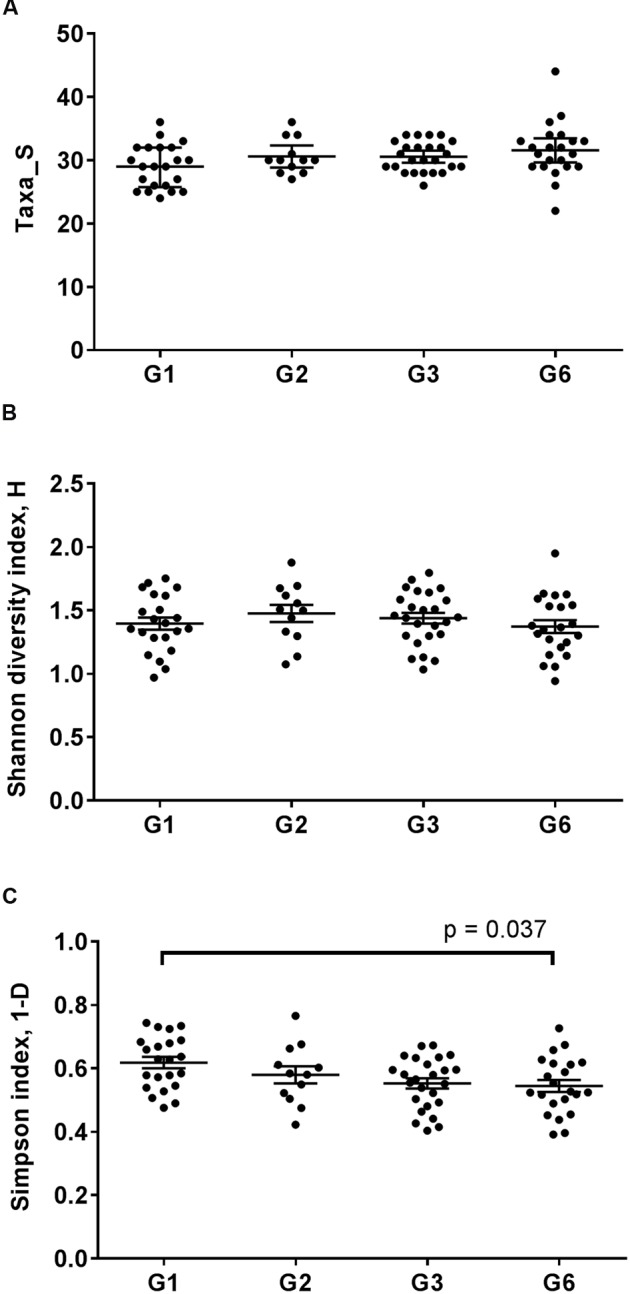
Alpha diversity analysis of the fecal microbiota of C57BL/6J inbred mice across four different generations. The fecal microbial diversity of mice were measured based on (A) microbial richness (B) Shannon-Wiener index H for microbial diversity and (C) Simpson index 1-D as a measure of microbial evenness, which takes into consideration microbial richness. Each point represents a sample. The middle bar represented the mean and the error bars represented the standard error of mean for each mice generation. The significance of differences between group means was determined using ANOVA with Bonferroni correction for pairwise comparisons.